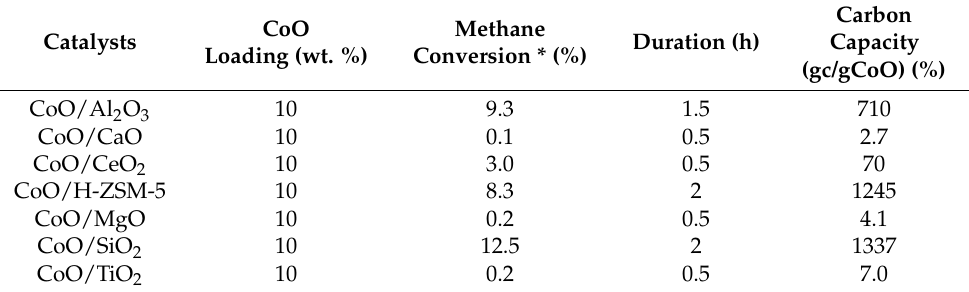
Table 1. The catalytic activity of cobalt catalysts on different supports at 550 ◦ C and 1 atm [38].